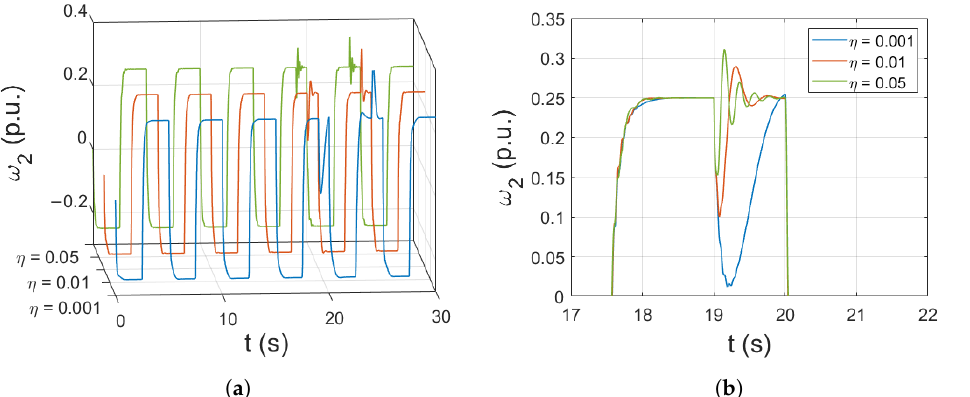
Figure 10. Different values of weight-related learning rate η ( a ), zoom of a selected part of simulation ( b